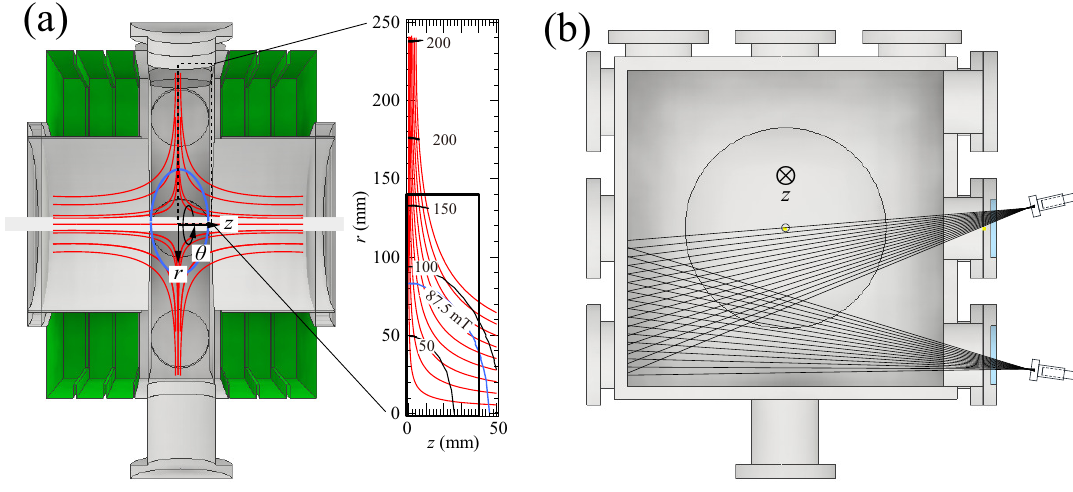
Figure 2. Schematic illustration of the electron cyclotron resonance (ECR) discharge device. ( a ) Frontal view plane of the device. The red and blue lines represent the magnetic field lines and the ECR surface, respectively. ( b ) A r θ -plane, where the viewing chords are aligned. The black lines represent the axes of the